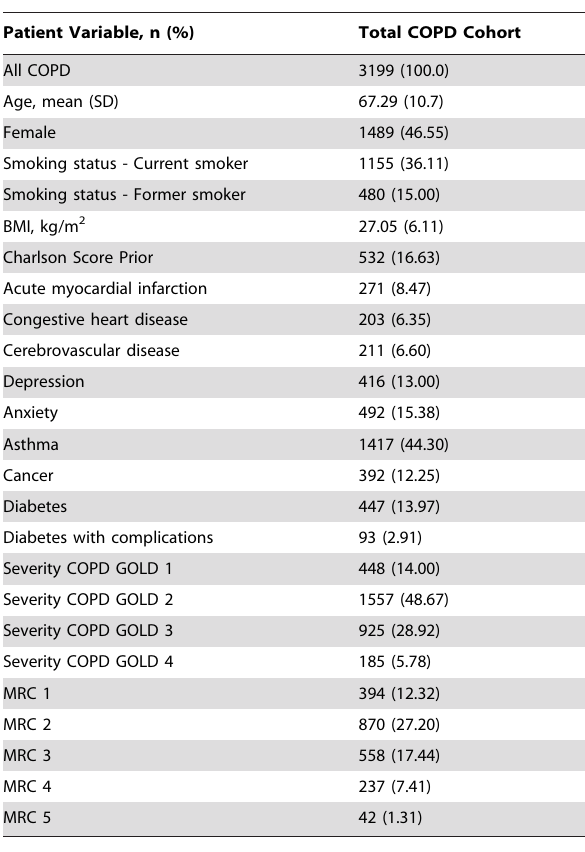
Abbreviations: BMI, body mass index; COPD, chronic obstructive pulmonary disease; GOLD, Global Initiative for Chronic Obstructive Lung Disease stage of airflow limitation; MRC, Medical Research Council dyspnea scale; SD, standard